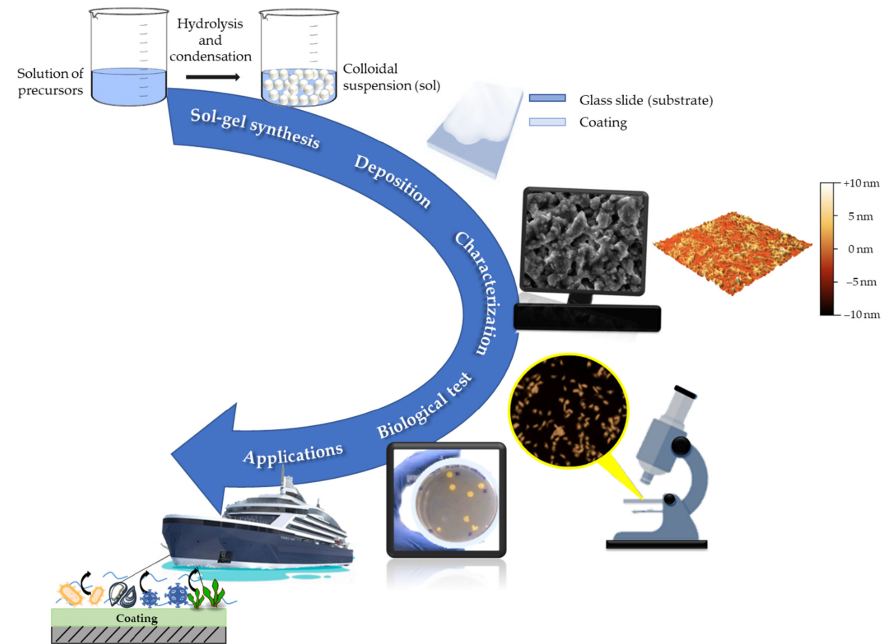
Figure 3. Overall aim of the work, from the FR sol–gel synthesis to blue growth